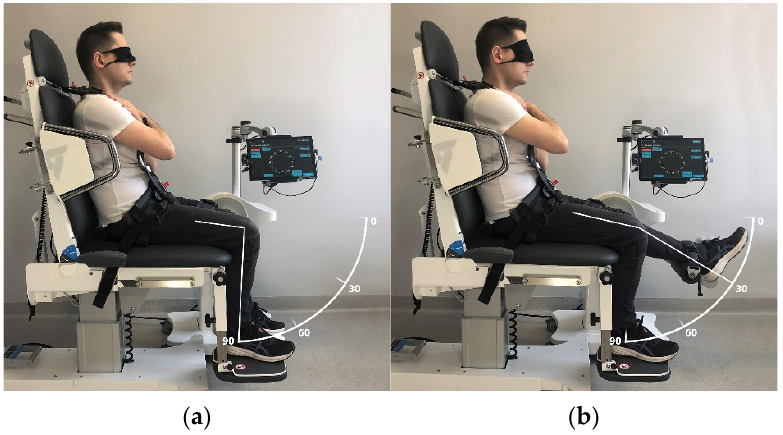
Figure 3. Knee extension joint position sense (JPS) measurement: ( a ) baseline position ; ( b ) target position.